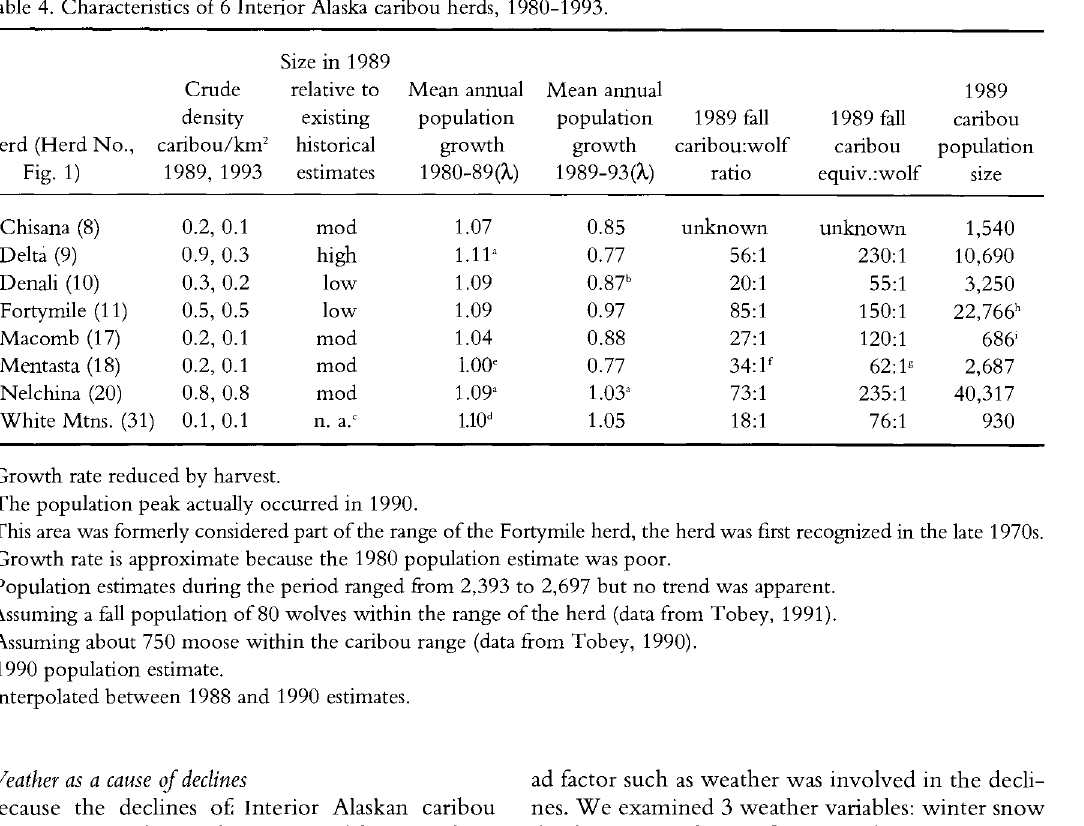
Table 4. Characteristics of 6 Interior Alaska caribou herds, 1980-1993.